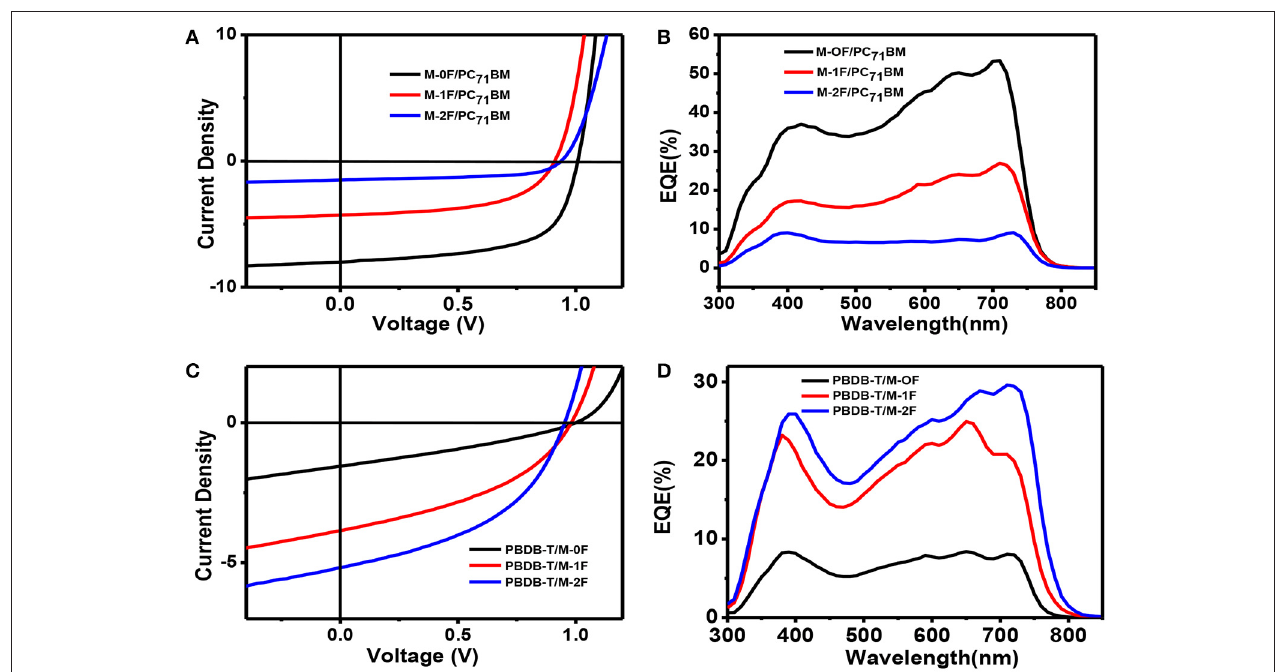
FIGURE 2 | (A,B) J–V curves and EQE curves of M-0F, M-1F, M-2F With PC 71 BM blends at the best performance condition. (C,D) J–V curves and EQE curves of M-0F, M-1F, M-2F with PBDB-T blends at the best performance condition.